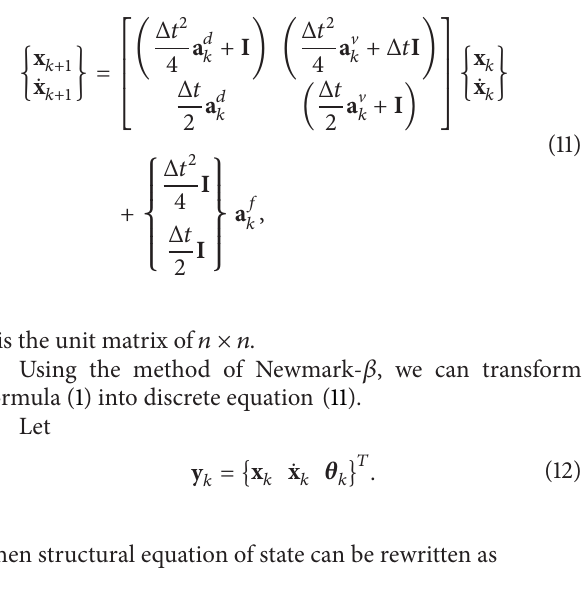
Figure 1: Structure diagram. Table 1: Structural